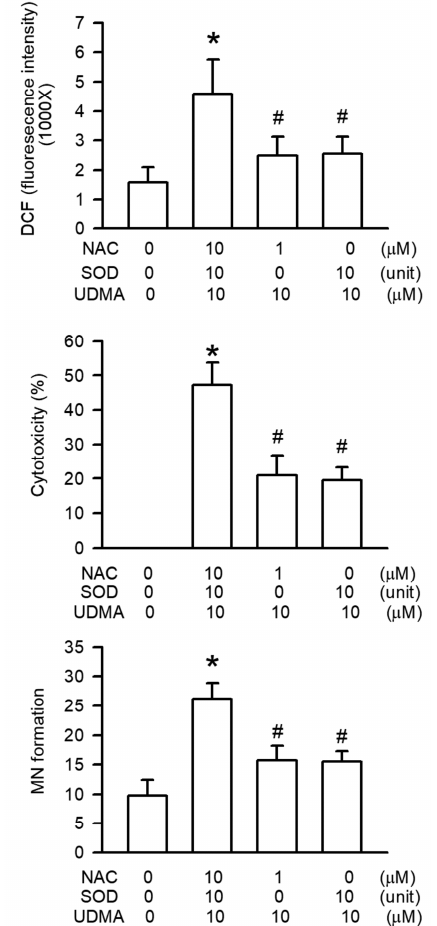
Figure 8. UDMA induced intracellular ROS generation in RAW264.7 macrophages. Data are expressed as mean ± SD (n = 5). *P < 0.05 is considered significant compared with control group.